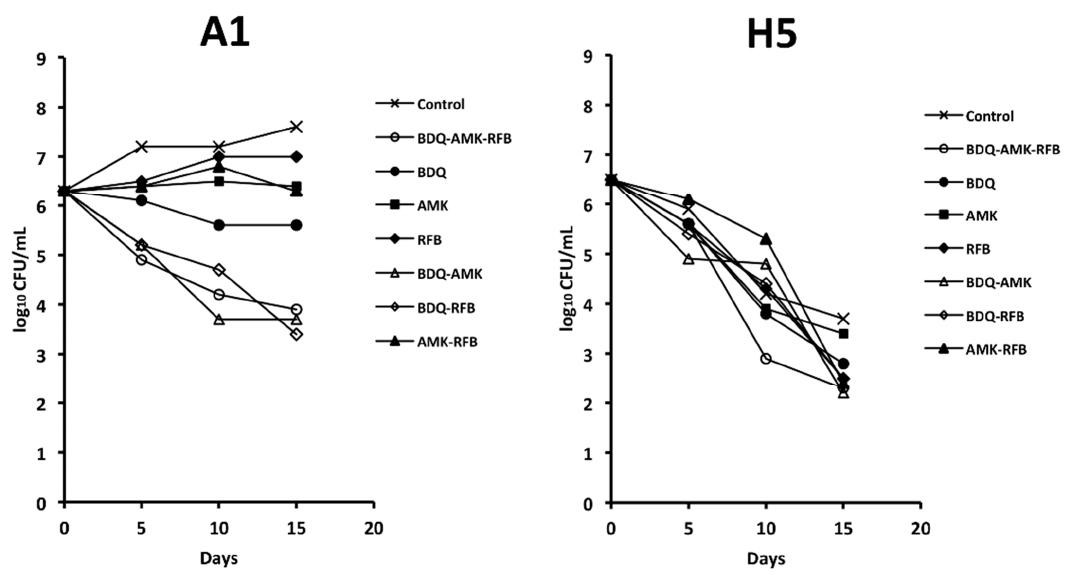
Figure 2. Survival of A1 and H5 cells of Mab-10 after exposure to bedaquiline (BDQ)-amikacin (AMK)-rifabutin (RFB), 2-drug components, and single drugs, as estimated by CFU counts. A representative experiment out of two is shown.